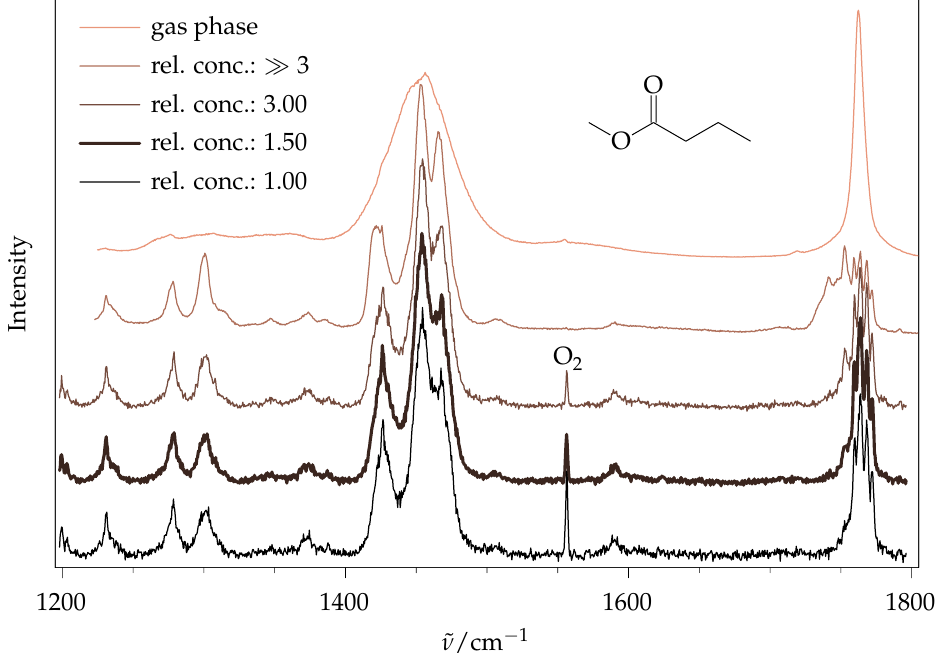
Figure 10. Raman spectra of methyl butanoate. Top trace: gas phase. Lower four traces: jet spectra with identical conditions, except for varying ester concentration. O 2 and H 2 O signals at 1556 and 1590cm − 1 are from air impurity.